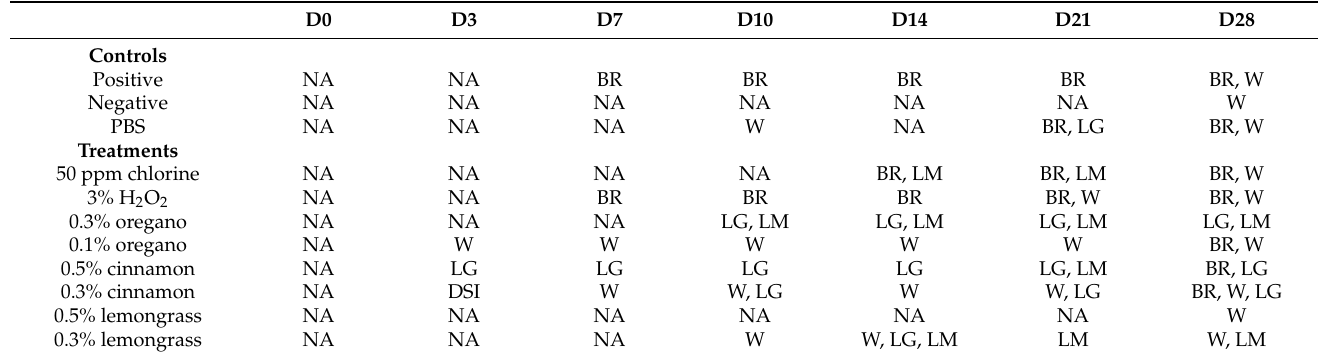
Table 1. Visual observation results of Iceberg lettuce inoculated with E. coli O157:H7, treated with plant- based microemulsions, 50 ppm chlorine, and 3% hydrogen peroxide and stored for 28 days at 4 ◦ C.